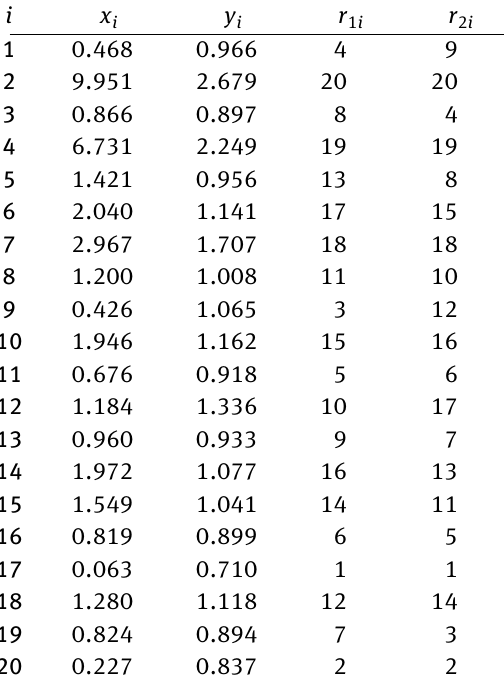
Table 1: The original data and the corresponding rank